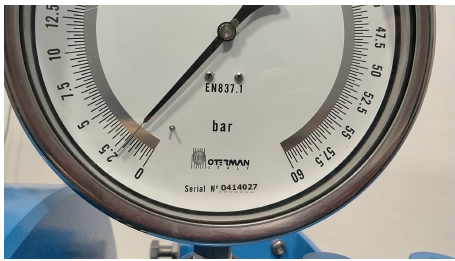
Figure 13. Pressure chamber manometer.